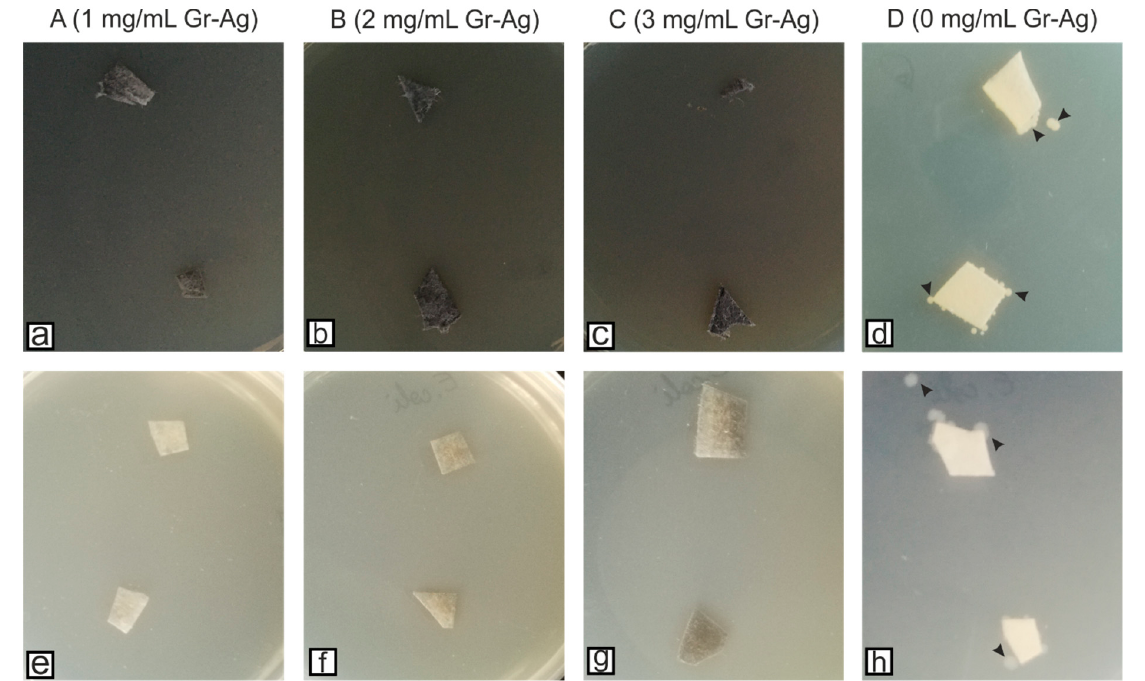
Figure 4. HEPA filters treated with different concentrations of Gr-Ag (5 wt% Ag) and the control filter incubated with S. aureus ( a – d ) and E. coli ( e – h ) for 24 h at 37 °C, and inoculated on fresh Mueller-Hinton agar media; black arrowheads indicate the presence of bacteria on the culture media (only the control filters had viable bacteria—D (0 mg/mL Gr-Ag). Based on the above measurements, we selected the optimum Gr-Ag (5 wt% Ag) concentration (2 mg/mL) and varied the immersion time: 15 (B 1 ), 30 (B 2 ), 45 (B 3 ) and 60 (B 4 ) min. The Gr-Ag (5 wt% Ag) loading on the HEPA filters was time-dependent, as in- dicated in Figure 5.